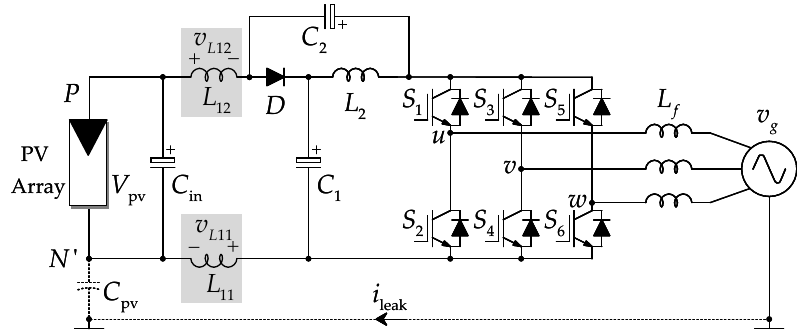
Figure 6. Modified quasi-Z source inverter system with a split